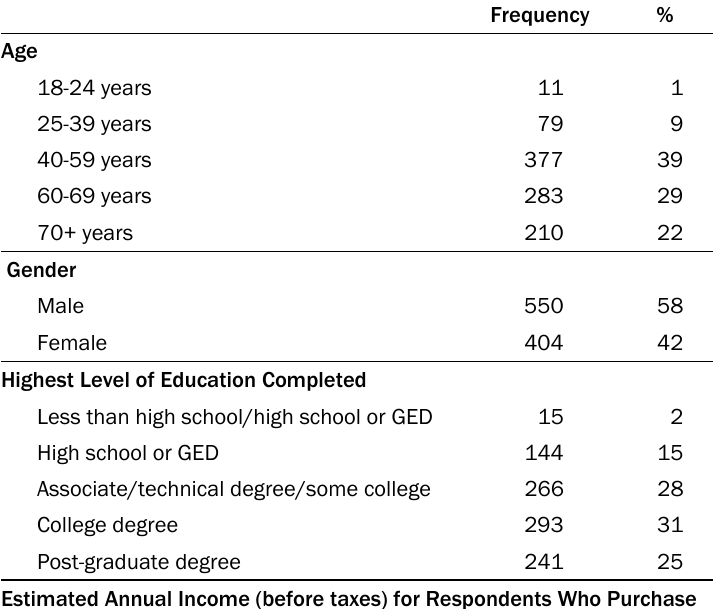
Table 1. Demographics of Survey Respondents ( N